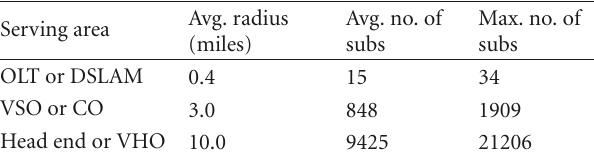
Table 3: Simulated serving area sizes for P2P results. Serving